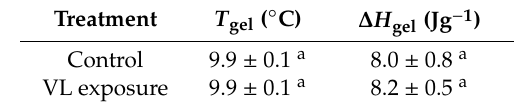
Table 1. Thermal properties of salmon gelatin–riboflavin (SG–Rf) pH 8.5 hydrogels.